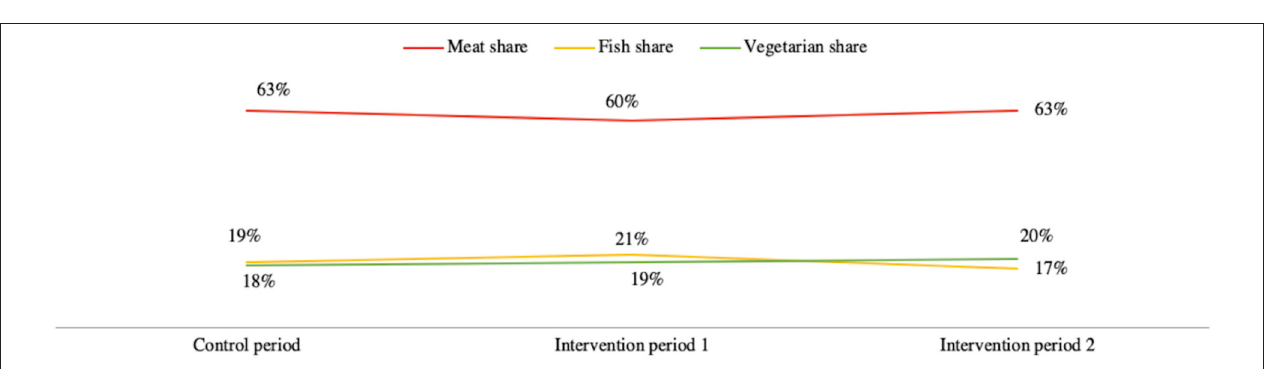
FIGURE 5 | Sales share of different dishes under single-red labels vs. no